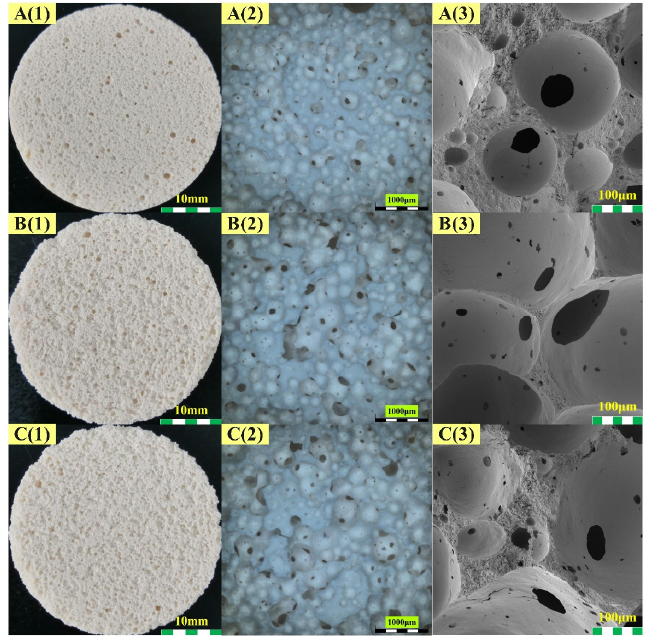
Figure 7. Morphology of geopolymer foams: (A) (1–3) H2P6, (B) (1–3) H3P6, (C) (1–3) H3P10).